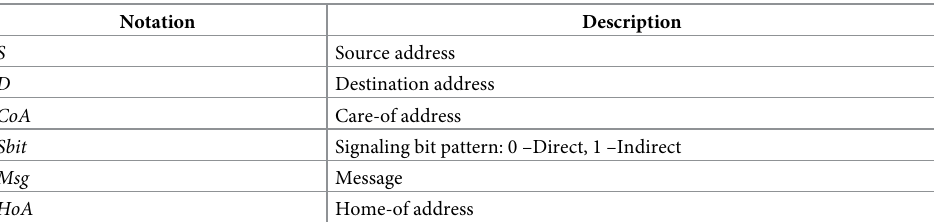
Table 2. Notations